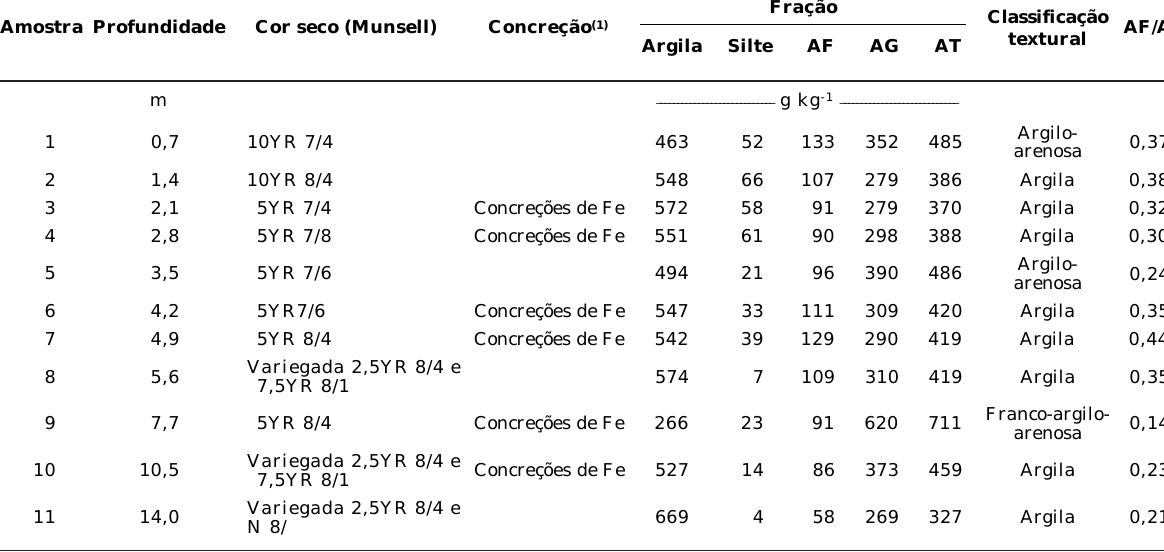
(1) Descrição morfológica, segundo Lemos & Santos (1996). Amostras 3, 6 e 9: concreções de Fe muito freqüente grande dura irregu- lar vermelho-escura a lilás. Amostras 4, 7 e 10: concreções de Fe freqüente grande dura irregular vermelho-escura a lilás. (2) AF – areia fina, AG – areia grossa e AT – areia total.